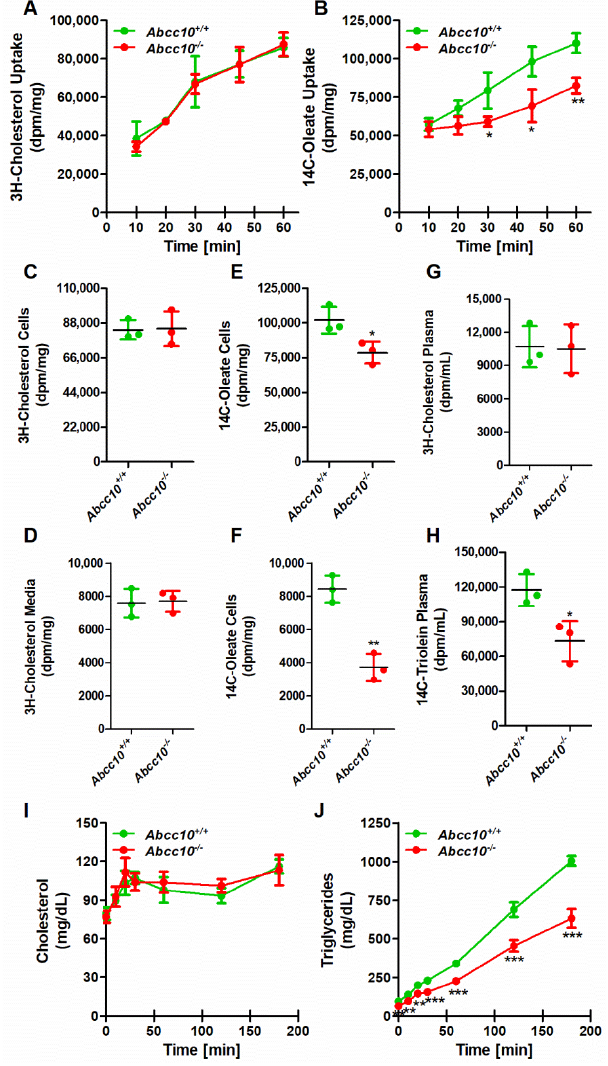
Figure 9. Absorption and secretion of triglycerides is decreased in Abcc10 -gene-deleted mice. Chow-diet-fed, 12-week-old Abcc10 +/+ and Abcc10 − / − male mice ( n = 3) were fasted overnight and used to isolate enterocytes. Enterocytes were labeled in DMEM media containing 0.5 μCi /mL of 3H-cholesterol or 14C-oleic acid and incubated at 37 °C. Cells were collected every 10 min and washed. Lipids were extracted to study the uptake of 3H-cholesterol ( A ) or 14C-oleic acid ( B ). After 1 h, enterocytes were washed and lipids were isolated to determine uptake of radiolabeled lipids. To study secretion of lipoproteins, enterocytes were isolated from overnight-fasted mice ( n = 3) and labeled for 1 h with 0.5 μCi /mL of 3H-cholesterol ( C , D ) or 14C-oleic acid ( E , F ). Enterocytes were washed and incubated with fresh media containing 1.4 mM oleic acid containing micelles. After 2 h, enterocytes were centrifuged and supernatants were collected to measure radiolabeled lipids in the media ( D , F ). Pellets were washed and lipids were isolated to determine the remaining cellular radiolabeled lipids ( C , E ). Age-matched 12-week-old chow-diet-fed Abcc10 +/+ and Abcc10 − / − male mice ( n = 3) were fasted overnight and injected intraperitoneally with P407 (30 mg/mouse). After 1